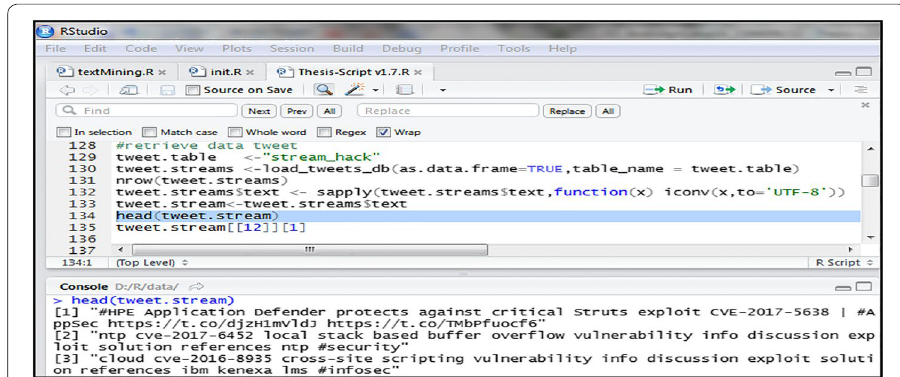
Fig. 3 Twitter data stored in MySQL local database. After data collection process has been done, all the data collected is stored in a MySQL